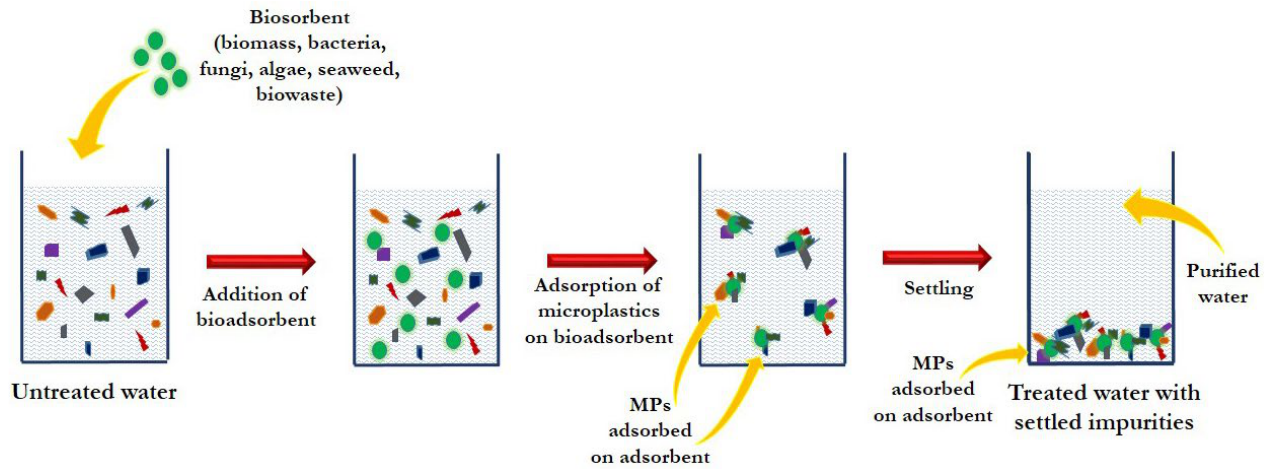
Figure 8. Schematic diagram illustrating the bio-adsorption of microplastics .